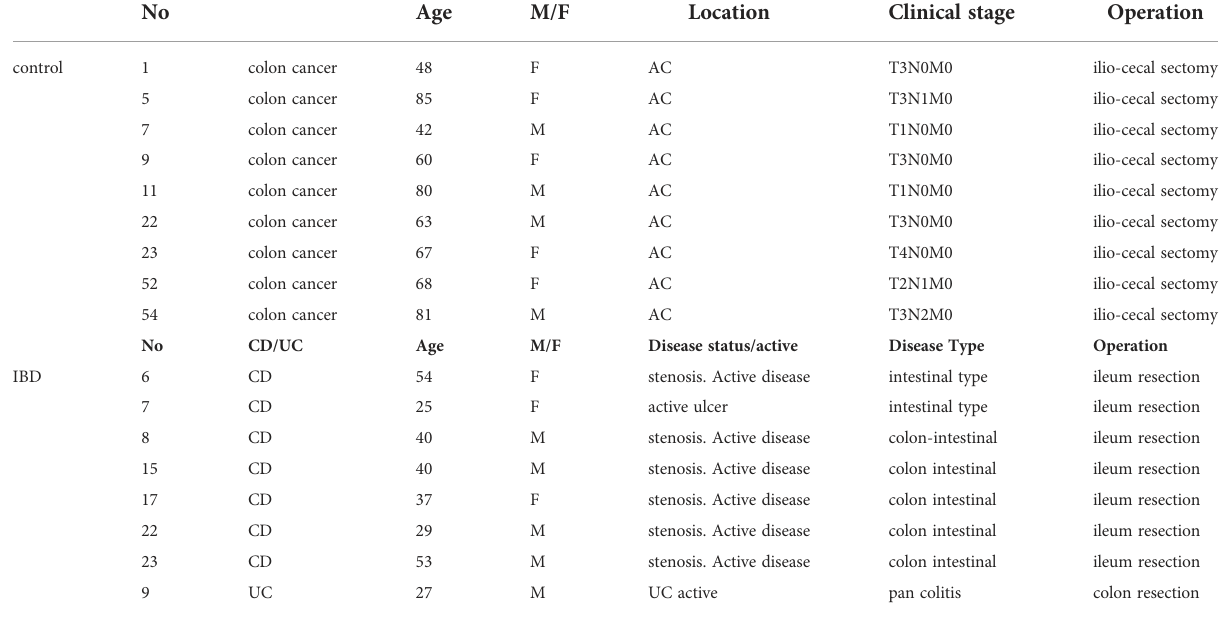
TABLE 1 Patient